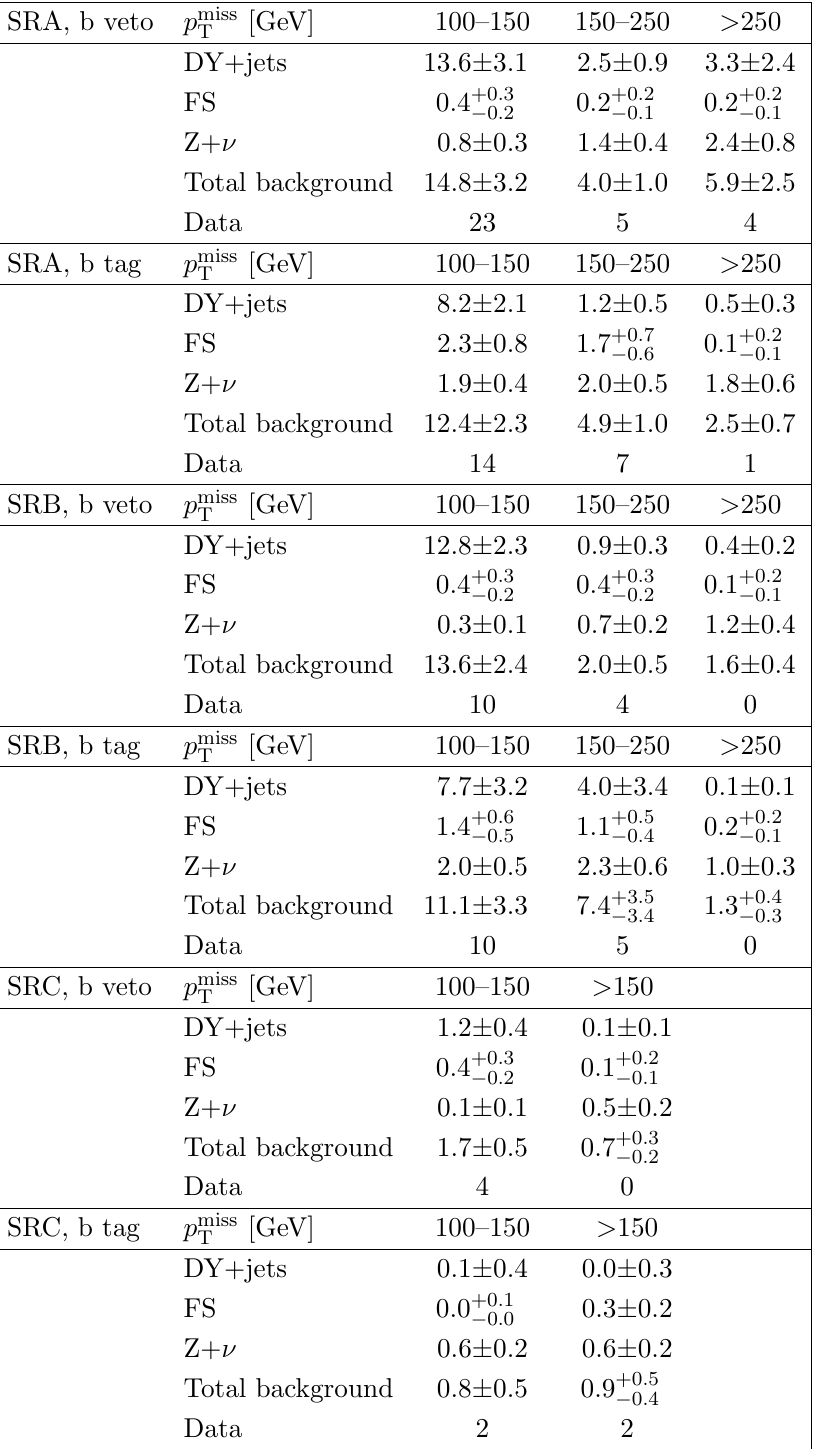
Table 2 . Predicted and observed event yields are shown for the on-Z strong-production SRs, for each p miss bin de(cid:12)ned in table 1. The uncertainties shown include both statistical and systematic T